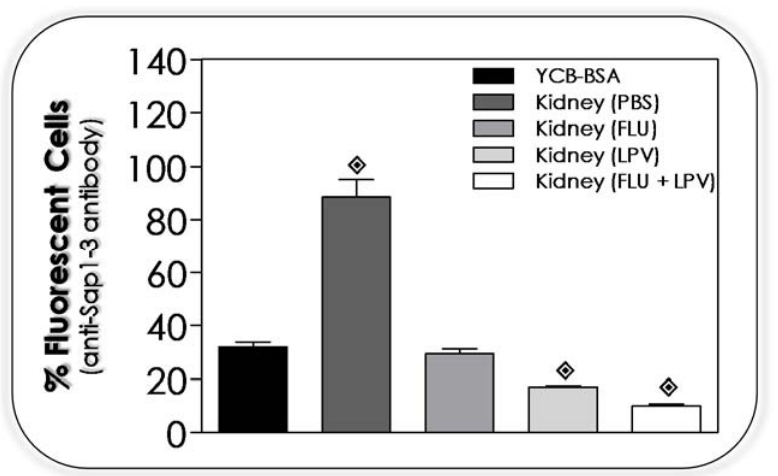
Figure 12. Effects of lopinavir on the expression of Sap1-3 antigens in C. albicans before and after passage in BALB/c mice. Yeast colonies isolated from the kidneys of infected mice, which were treated with PBS, fuconazole (10 mg/mL), lopinavir (10 mg/mL) and fluconazole + lopinavir (both at 10 mg/mL) were grown in YCB-BSA medium at 37 °C for 48 h, and then the expression of Sap antigens was evaluated by flow cytometry using an antibody raised against Sap1-3. Yeasts only grown in axenic conditions were run in parallel as a control. The percentage of Sap1-3-labeled yeasts is shown. The values represent the mean ± standard deviation of three independent experiments performed in triplicate. The symbols indicate the experimental systems considered statistically significant from the control (yeasts grown in vitro in YCB-BSA medium) ( p < 0.05; ANOVA followed by Tukey-Kramer